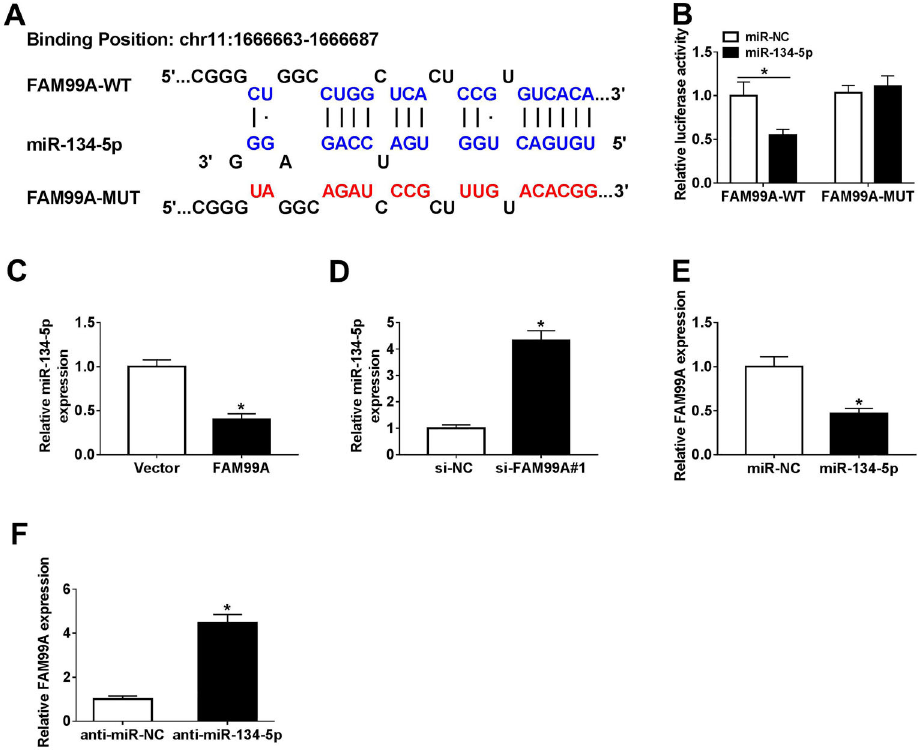
Figure 3. A , The complementary binding sites between FAM99A wild type (WT) and miR-134-5p are shown, as well as the sequences of FAM99A mutant (MUT). B , The luciferase activity of FAM99A-WTor FAM99A-MUT in HTR8/SVneo cells transfected with miR-134-5p or miR-NC was assessed via dual-luciferase reporter assay. C and D, The level of miR-134-5p in HTR8/SVneo cells transfected with FAM99A, si-FAM99A#1, or negative controls was measured by qRT-PCR. E and F , The level of FAM99A in HTR8/SVneo cells transfected with miR-134-5p, anti-miR-134-5p, or negative controls (NC) was detected via qRT-PCR. Data are reported as means ± SD. *P o 0.05 (Student ’ s t